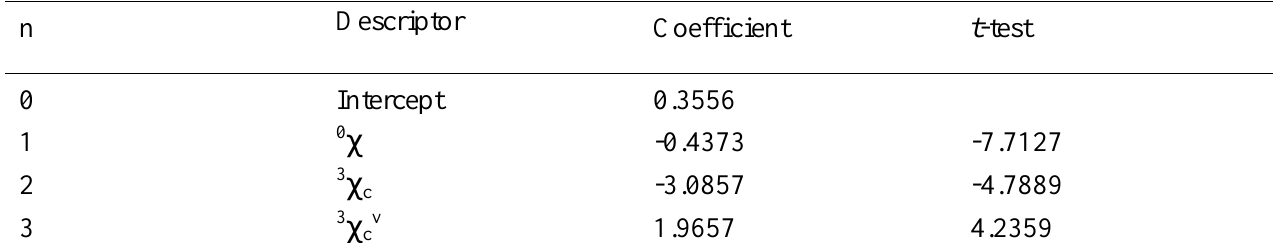
Table 2. The best correlation model of logSw of 50